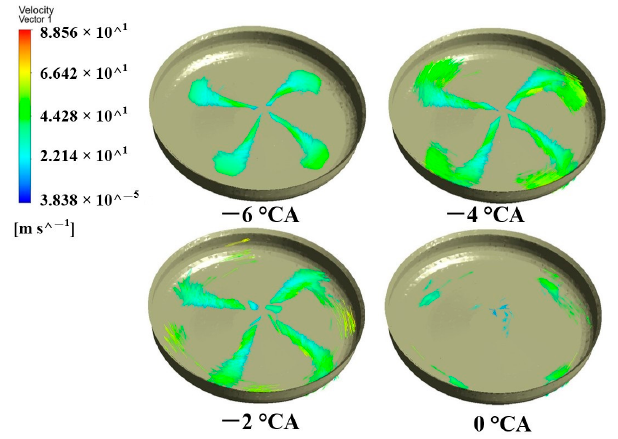
Figure 8. Velocity vector diagram of heavy fuel.